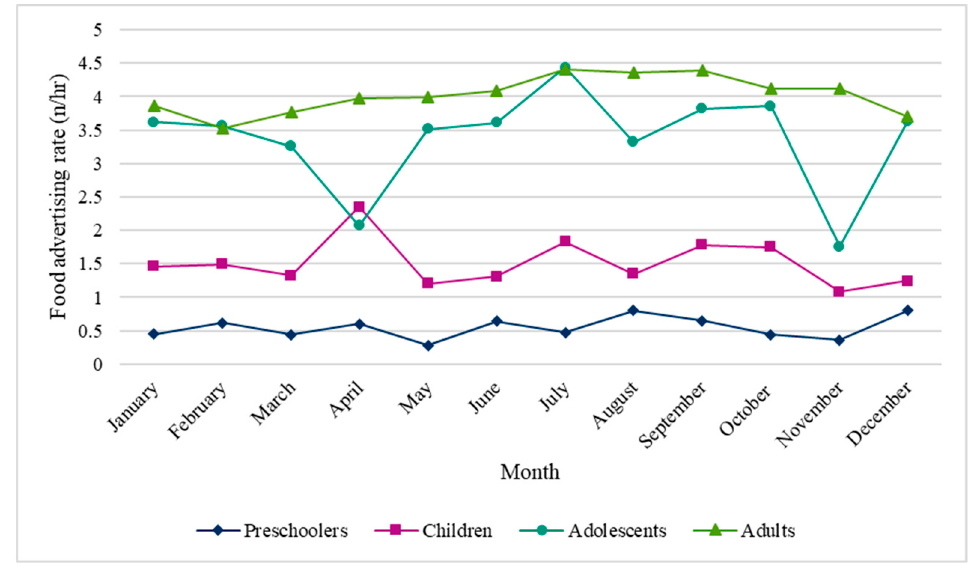
Figure 1. Monthly age-specific food advertising rates, in terms of food ads per hour of programming, on Canadian television stations, in 2018.